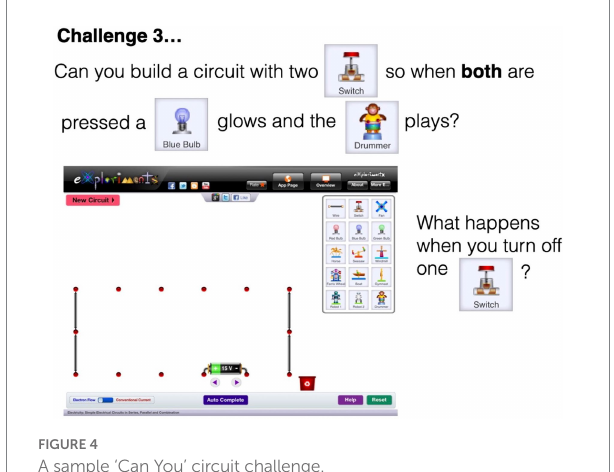
FIGURE 4 A sample ‘Can You’ circuit